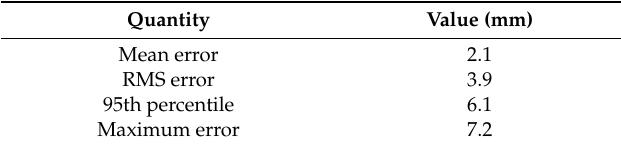
Table 2. Descriptive statistics of the error of the dynamic scan in indoor tests.